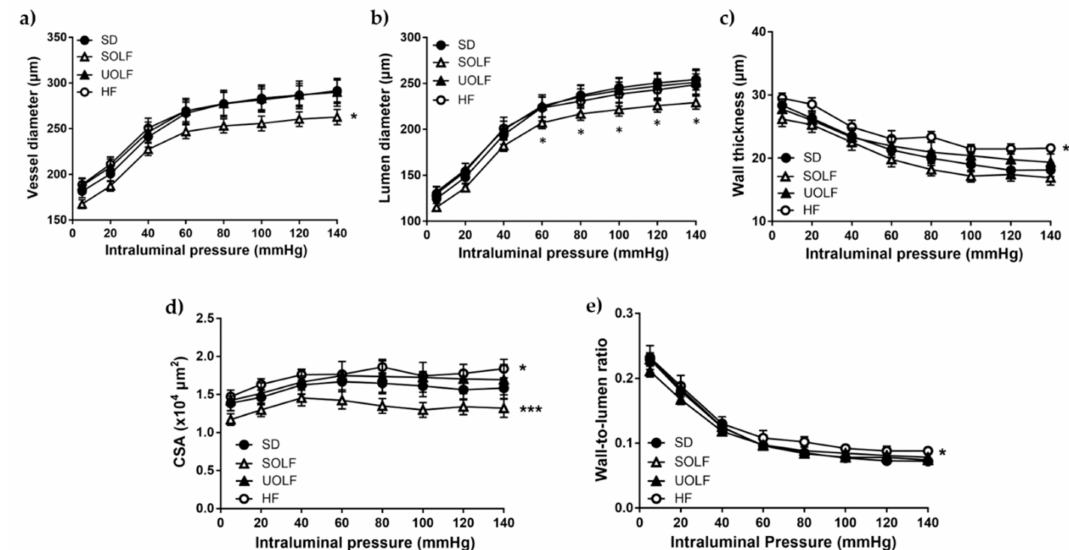
Figure 3. Characterization of structural parameters in first order mesenteric resistance arteries. ( a ) Vessel diameter–pressure, ( b ) lumen diameter–pressure, ( c ) wall thickness-pressure, ( d ) cross sectional area (CSA) pressure, and ( e ) media to lumen ratio-pressure of mesenteric resistance arteries (MRA) from SD, UOLF, SOLF, and HF mice. Results are expressed as mean ± SEM of n = 7–10. * p < 0.05 and *** p < 0.001 vs. the SD group.